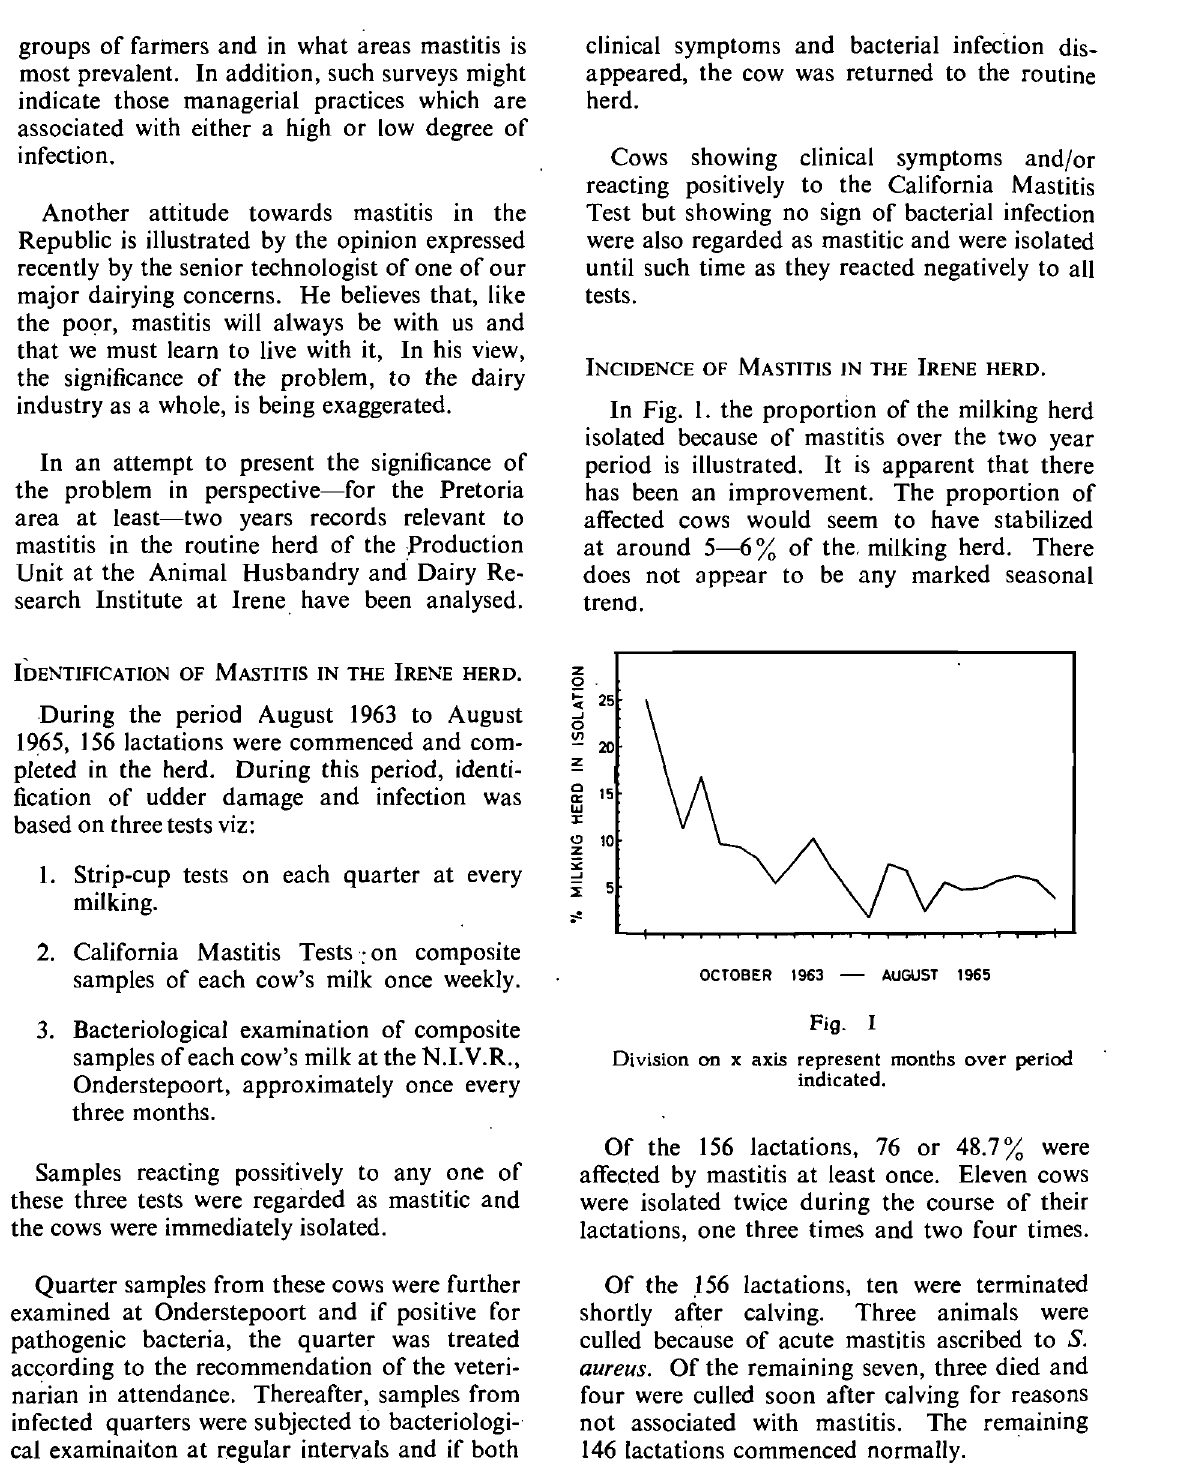
Division on x axis represent months over period